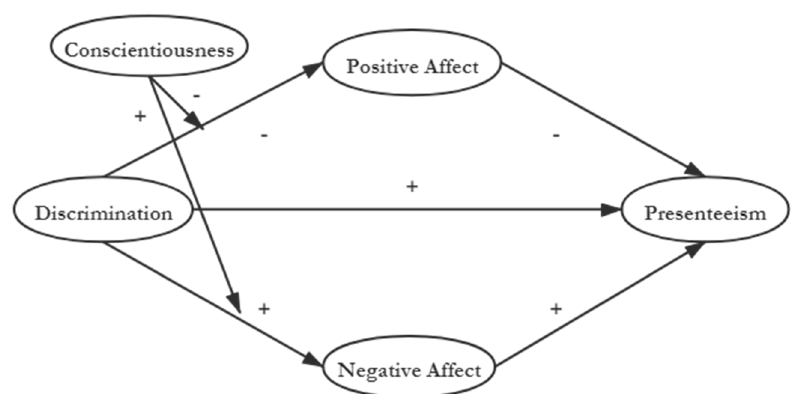
Figure 1. Proposed model of the relationship between discrimination, presenteeism, and positive and negative affect shows the effect of mediator resources, with conscientiousness as moderator.